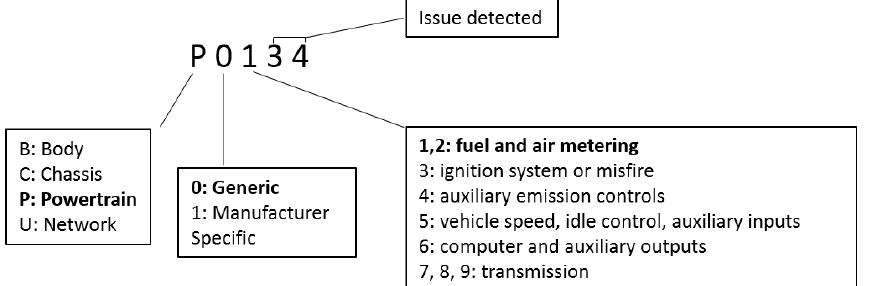
Figure 3. Breakdown of OBD-II diagnostic trouble codes sent by engine control unit to indicate any issues detected.